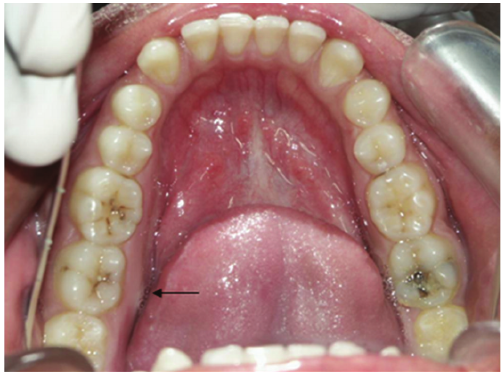
Figure 4: Lateral occlusal radiograph of right side mandible showing expansion of buccal and lingual